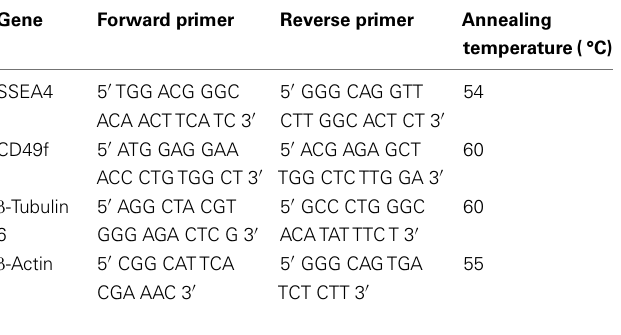
Table 3 | Primers used for RT-PCR.